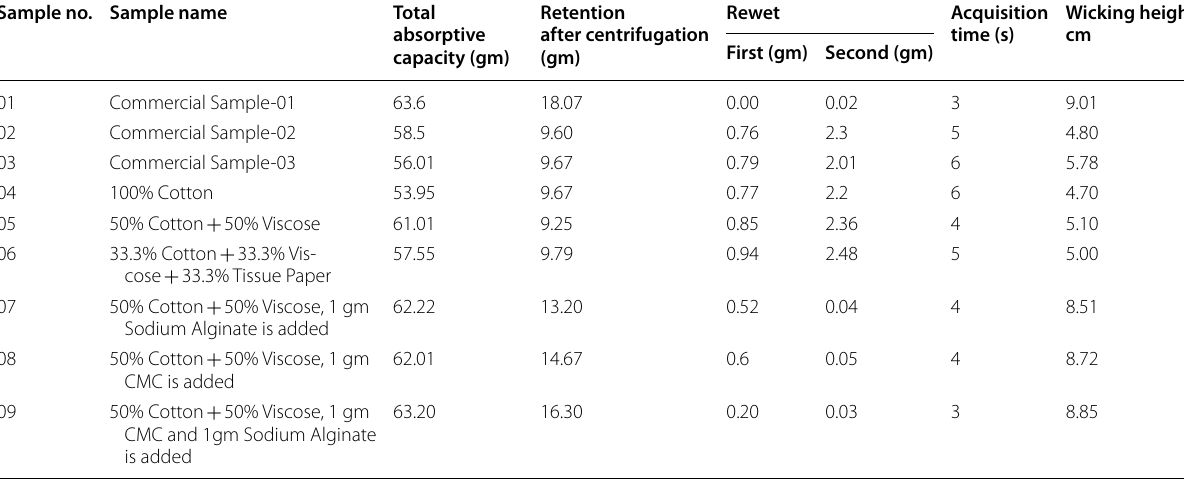
Table 3 Comparison of quality between commercial and developed pad samples Sample no. Sample